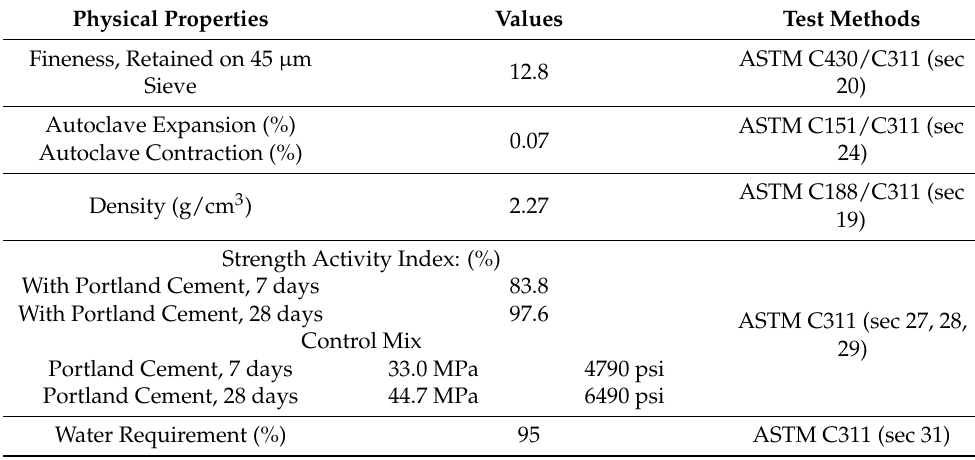
Table 3. Physical properties of fly ash (provided by manufacturer).